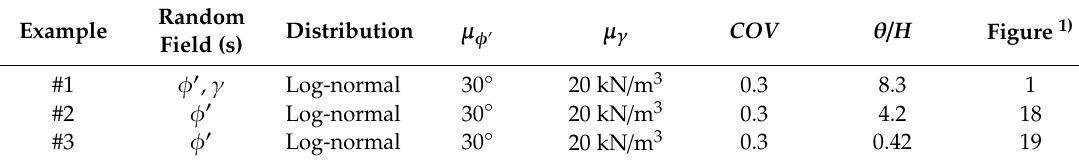
Table 1. Summary of the soils’ characteristics used in the three examples (wall height H = 2.4 m).